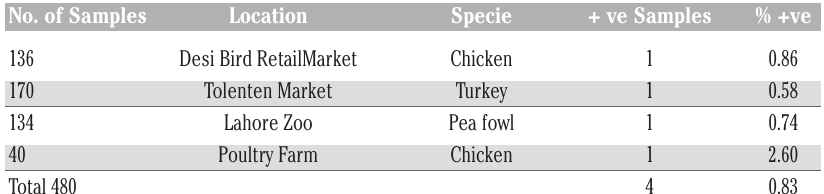
Table 1. Isolation of the h9 subtype avian influenza viruses.